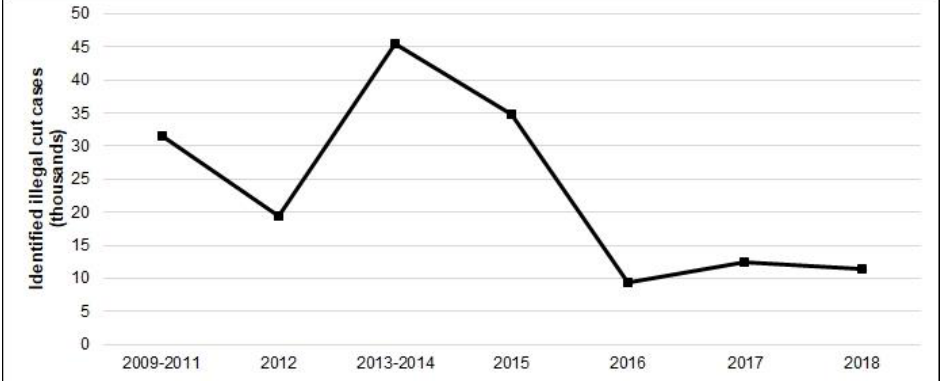
Figure 7. The evolution of identified illegal cutting cases in Romania, 2009 – 2018 (data source: [131]).